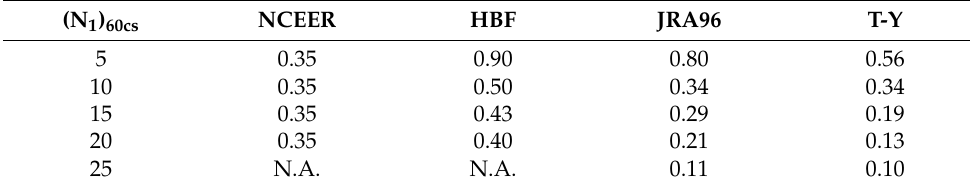
Table 5. Calibrated C_Finn